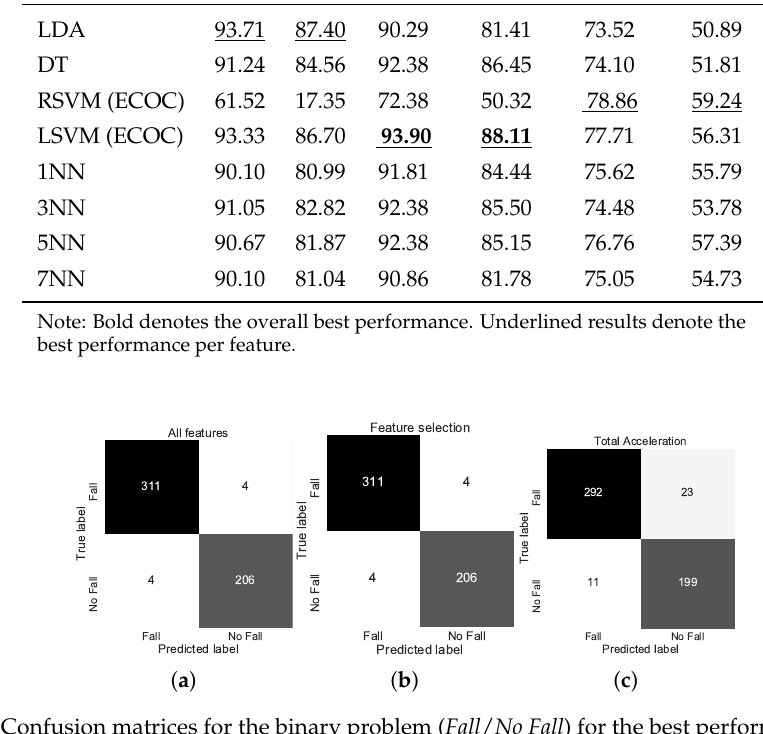
Figure 4. Confusion matrices for the binary problem ( Fall / No Fall ) for the best performing classifier using ( a ) all features (LSVM), ( b ) feature selection (7NN), and ( c ) the total acceleration features